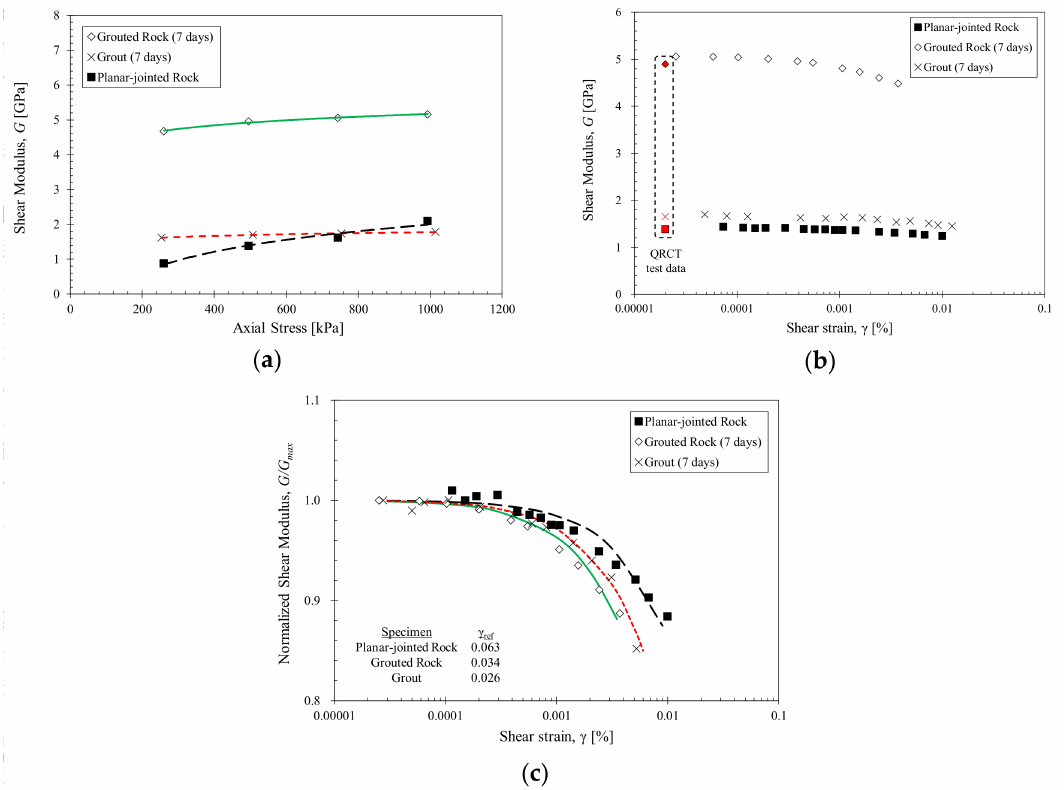
Figure 3. Stress- and strain-dependent properties of the planar-jointed rock, grouted rock (7 days of curing), and grout specimens (7 days of curing). ( a ) Stress-dependent small-strain shear modulus for 250, 500, 750 and 1000 kPa axial stress; ( b ) Strain-dependent shear modulus at 500 kPa axial stress. The small-strain shear modulus shown in red is obtained from the small-strain shear wave velocity; ( c ) Normalized shear modulus degradation curve. The data is fitted using the hyperbolic